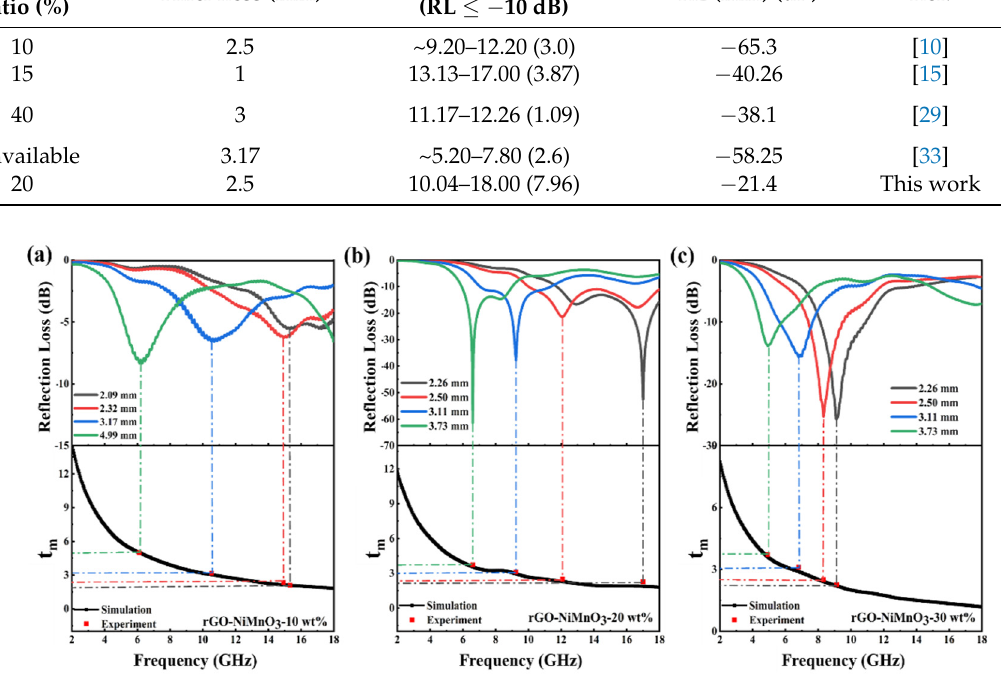
Figure 7. Comparison of various absorber thickness ( t m ) for ( a ) rGO-NiMnO 3 -10 wt%, ( b ) rGO- NiMnO 3 -20 wt%, and ( c ) rGO-NiMnO 3 -30 wt% with the simulated thickness under λ /4 conditions at the frequency of maximum reflection loss values ( f m ). Table 1. Microwave absorption properties of carbon-based nanocomposites.